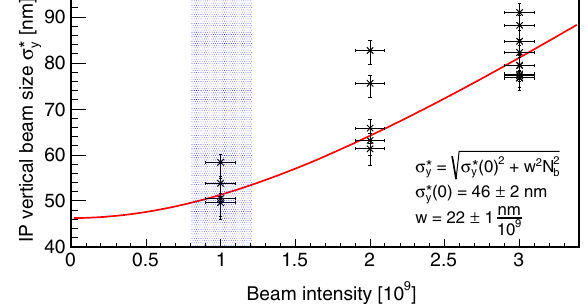
FIG. 9. Intensity dependence of IP vertical beam size for half β (cid:1) 10 β (cid:1) y , x optics. Black points stand for the measured beam size, red curve for the fit according to Eq. (11) and blue band for the bunch intensity restriction of the tuning and final beam size measurement.